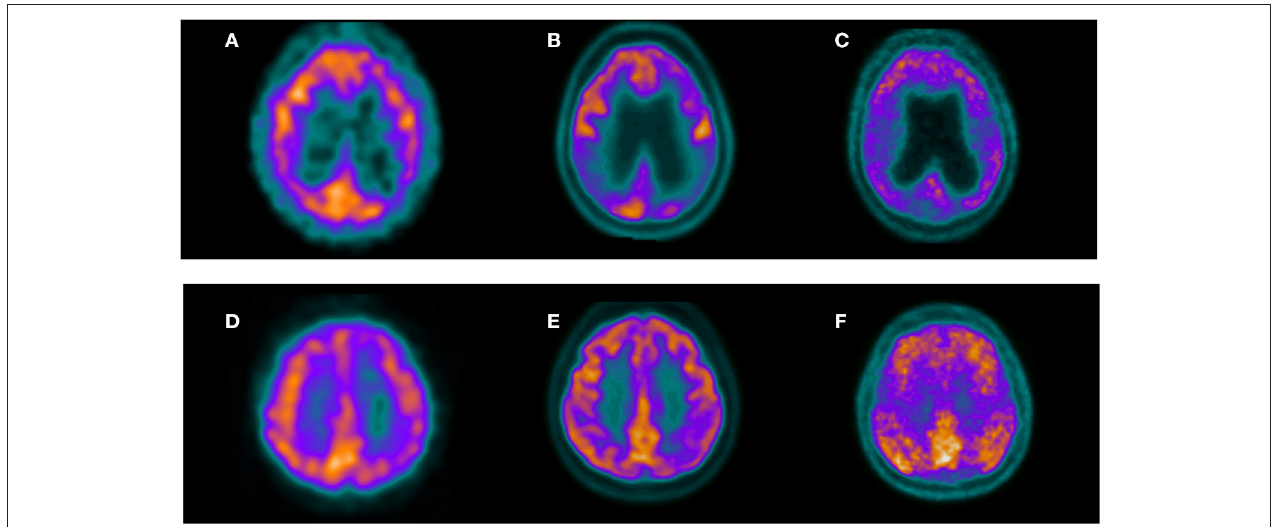
FIGURE 2 | Three selected transaxial slices of the perfusion SPECT, 18 F-FDG PET, and 11 C-PIB PET of two patients referred for clinical evaluation of cognitive impairment. Superior row corresponds to a 63-year-old female with a mild cognitive impairment. MMSE was 27. Both perfusion SPECT (A) and 18 F-FDG PET (B) showed hypoperfusion/hypometabolism in the bilateral parietal cortex with a typical pattern of AD. Amyloid PET in this patient (C) showed significant cortical amyloid deposits. Inferior row shows a 55-year-old female referred for evaluation of probable AD. Both perfusion SPECT (D) and 18 F-FDG PET (E) showed a left posterior parietal hypoperfusion/hypometabolism suggestive of AD. 11 C-PIB PET in this patient (F) confirmed cortical amyloid deposits.